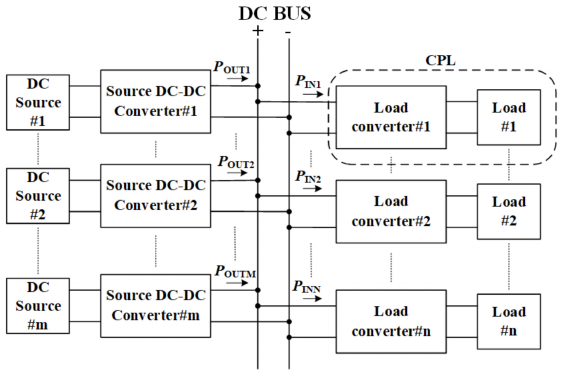
Figure 1. Typical diagram of